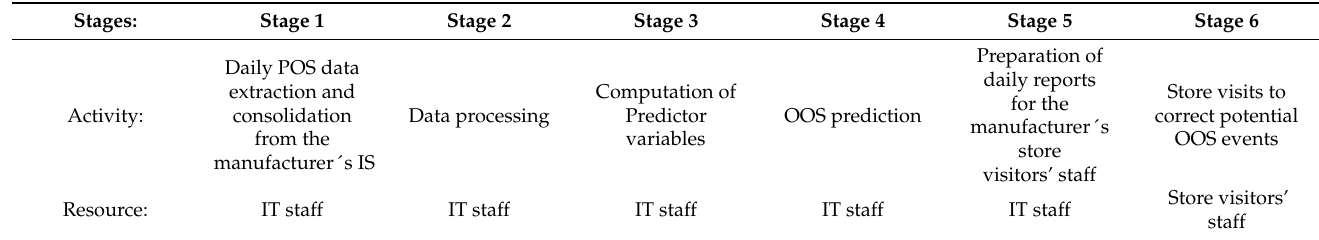
Table 8. Machine Learning Based System framework.